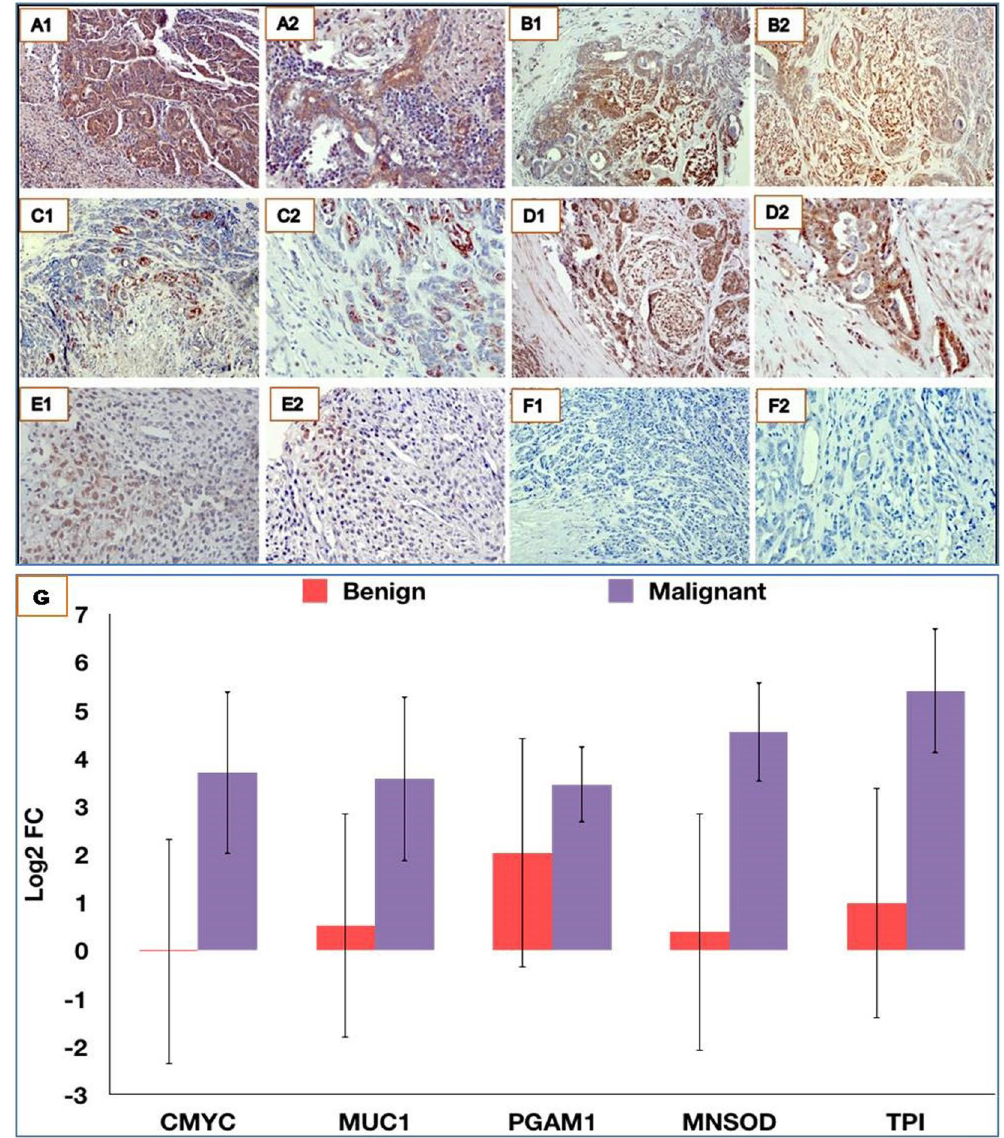
Figure 3. Overexpression of TPI, MNSOD, PGAM1, MUC1 & CMYC in canine mammary tumours. Immunohistochemical analysis at 10X ( A1 – E1 ) and 20X ( A2 – E2 ) revealed over expression of TPI ( A1 , A2 ), MNSOD ( B1 , B2 ), PGAM1 ( C1 , C2 ), MUC1 ( D1 , D2 ) and CMYC ( E1 , E2 ) in CMTs. F1(10X) & F2(20X) represent isotype controls. ( G ) qRT-PCR analysis also indicated overexpression of these biomarkers in CMT